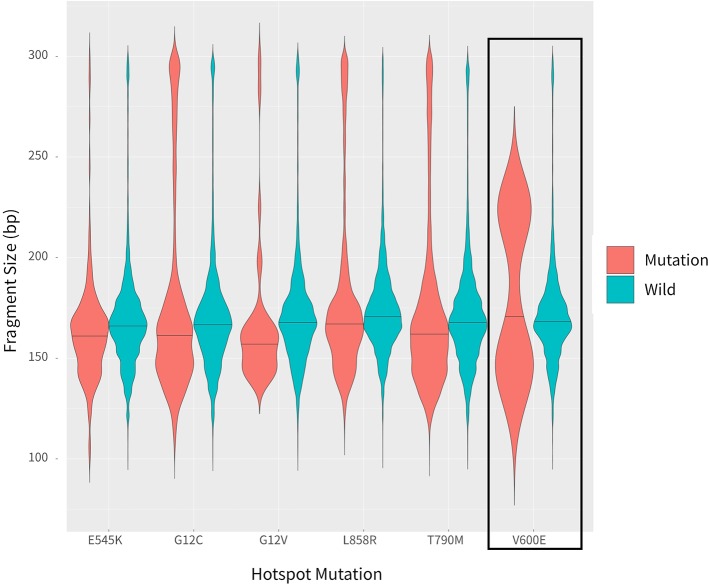
Comparison of fragment length sizes between ctDNAs and normal cfDNAs.